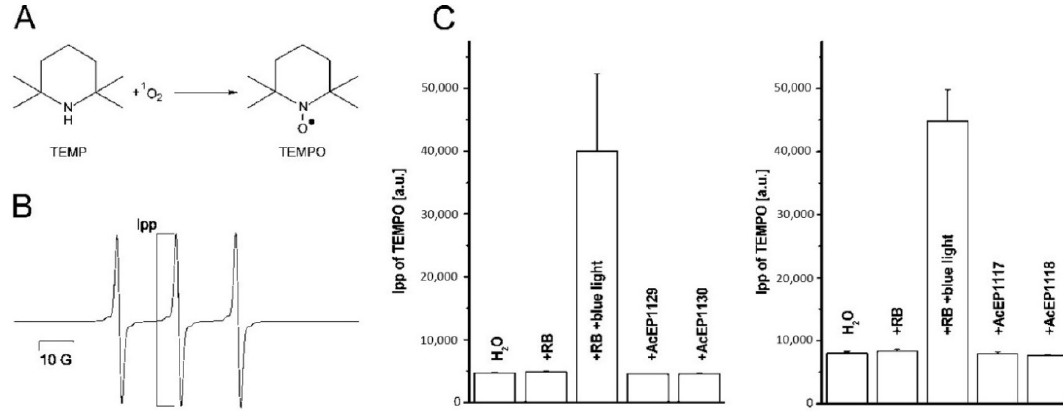
Figure 4. Peak-to-peak intensity (Ipp) of the EPR signals resulting from TEMP oxidation by 1 O 2 . ( A ) Scheme of the reaction of TEMP with 1 O 2 resulting in the formation of TEMPO. ( B ) Singlet oxygen reacts with TEMP to TEMPO, a stable nitroxyl radical, resulting in a three-line spectrum. ( C ) Each of 100 µM of AcEP1117, AcEP1118, AcEP1129, or AcEP1130 in H 2 O were incubated for 5 min at 25 °C in the presence of 50 mM TEMP. Samples containing 50 mM TEMP and rose bengal (40 µM, RB) served as the positive control. Samples containing 50 mM TEMP in H 2 O only were used as negative control. The positive control was measured in addition after irradiating the samples with blue light (465 nm) for 15 min. Data represent mean ± SD ( n = 3).